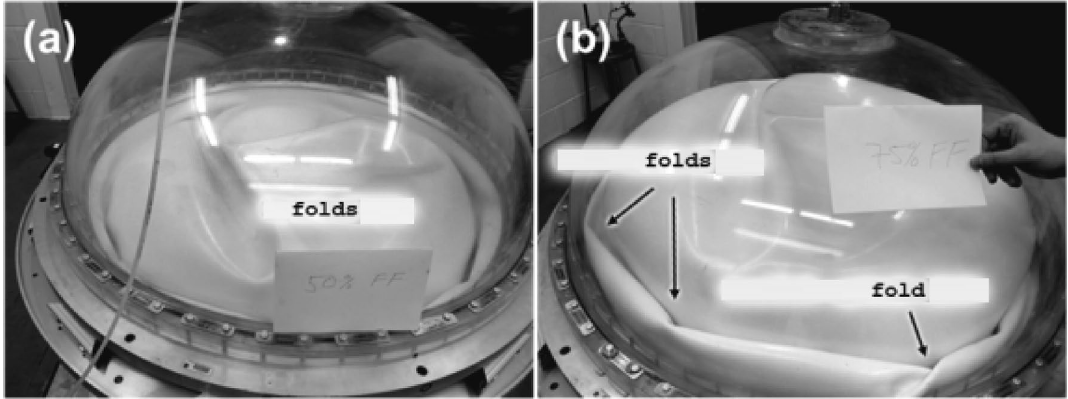
Fig. 2 Diaphragm folding shape in a 40-inch tank, ( a ) 50% fill fraction, ( b ) 75% fill fraction (Levine